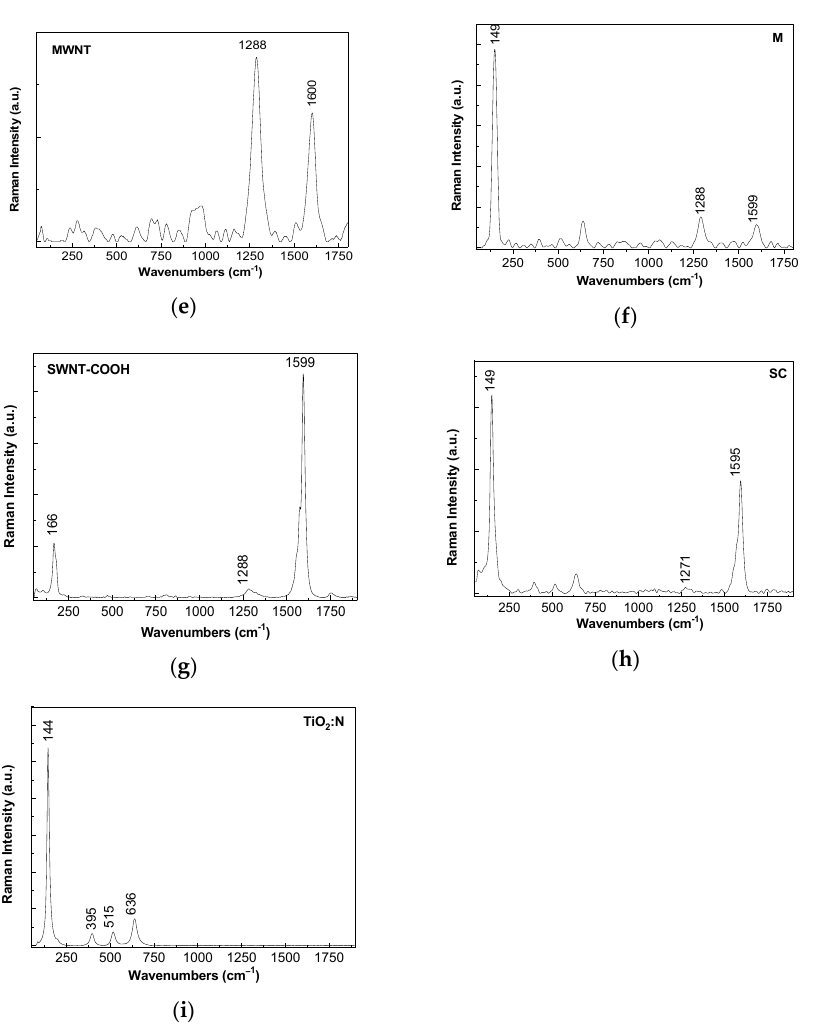
Figure 4. Raman spectra of the samples of SWNTs ( a ), TiO 2 :N/SWNTs (S2 sample) ( b ), DWNTs ( c ), TiO 2 :N/DWNTs (D sample) ( d ), MWNTs ( e ), TiO 2 :N/MWNTs (M sample) ( f ), SWNTs-COOH ( g ), TiO 2 :N/SWNTs-COOH (SC sample) ( h ), and TiO 2 :N ( i ) recorded at the excitation wavelength of 1064 nm. Raman lines of the TiO 2 :N nanoparticles peaked at 144, 395, 515, and 636 cm − 1 , being assigned to the E g(1) , B 1g(1) , A 1g , and E g(3) vibrational modes [27,28,29]. The following changes are remarked in the following cases: (i) S2 sample, a down-shift of the Raman lines from 164 cm − 1 and 1269 cm − 1 (Figure 4a) to 162 cm − 1 and 1265 cm − 1 (Figure 4b), re- spectively, simultaneously with the change of the ratio between the intensities of the RBM and TM Raman lines (I RBM /I TM ) from 0.75 (Figure 4a) to 1.35 (Figure 4b); (ii) D sample, an up-shift of the Raman lines from 264 cm − 1 (Figure 4c) and 144 cm − 1 (Figure 4i) to 268 cm − 1 and 149 cm − 1 (Figure 4d), respectively, accompanied by a down-shift of the Raman lines from 328 cm − 1 (Figure 4c) to 314 cm − 1 (Figure 4d) and a change of the ratio between the intensities of the D and TM bands (I D /I TM ) from ~0.1 (Figure 4c) to 0.37 (Figure 4d); (iii) M sample, a change of the ratio between the intensities of the D and TM bands of MWNTs (I D /I TM ) from 1.44 (Figure 4e) to 1.3 (Figure 4f), the E g vibrational mode of the TiO 2 :N na- noparticles being peaked at 149 cm − 1 ; and (iv) SC sample, the change of the ratio between Figure 5. Cont